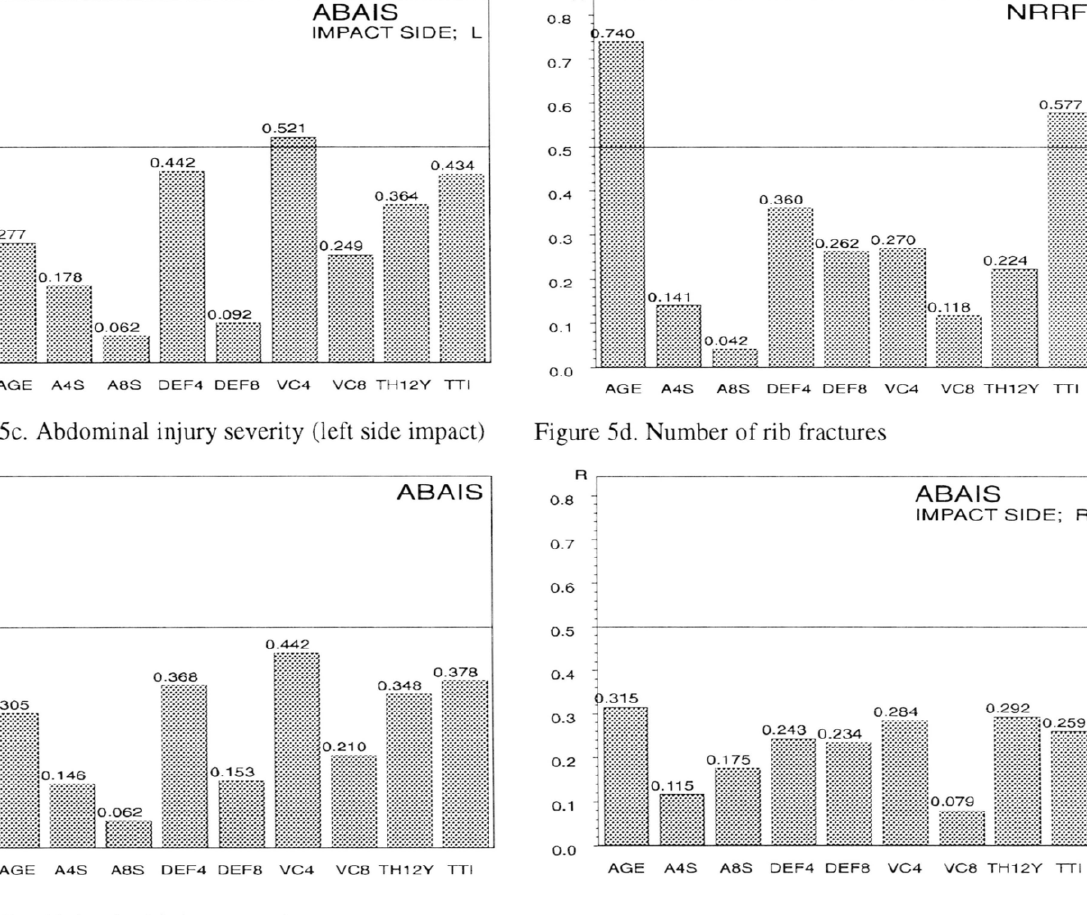
Figure Se. Abdominal injury severity Figure Sf. Abdominal injury severity (right side impact) FIGURE 5 Spearman correlation of thoracic, trunk, and abdominal injury severity vs. age, measured, and evaluated mechanical